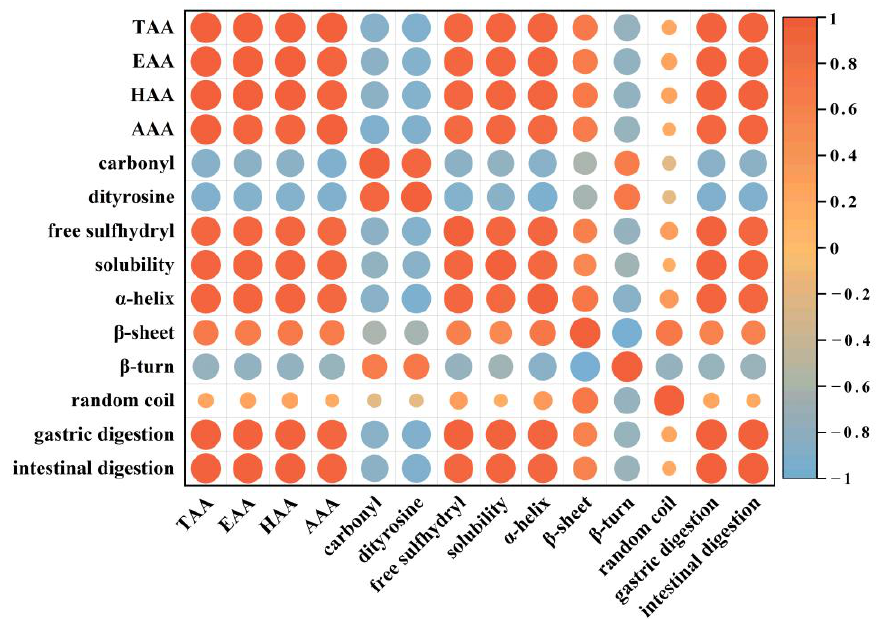
Figure 10. Pearson correlation of the different indexes in walnut kernels with different packaging, which were stored at 40 °C, 70% relative humidity for 0, 15, 30, 45, and 60 days. In the figure, the color gradation and circle size correspond to the correlation coefficient.